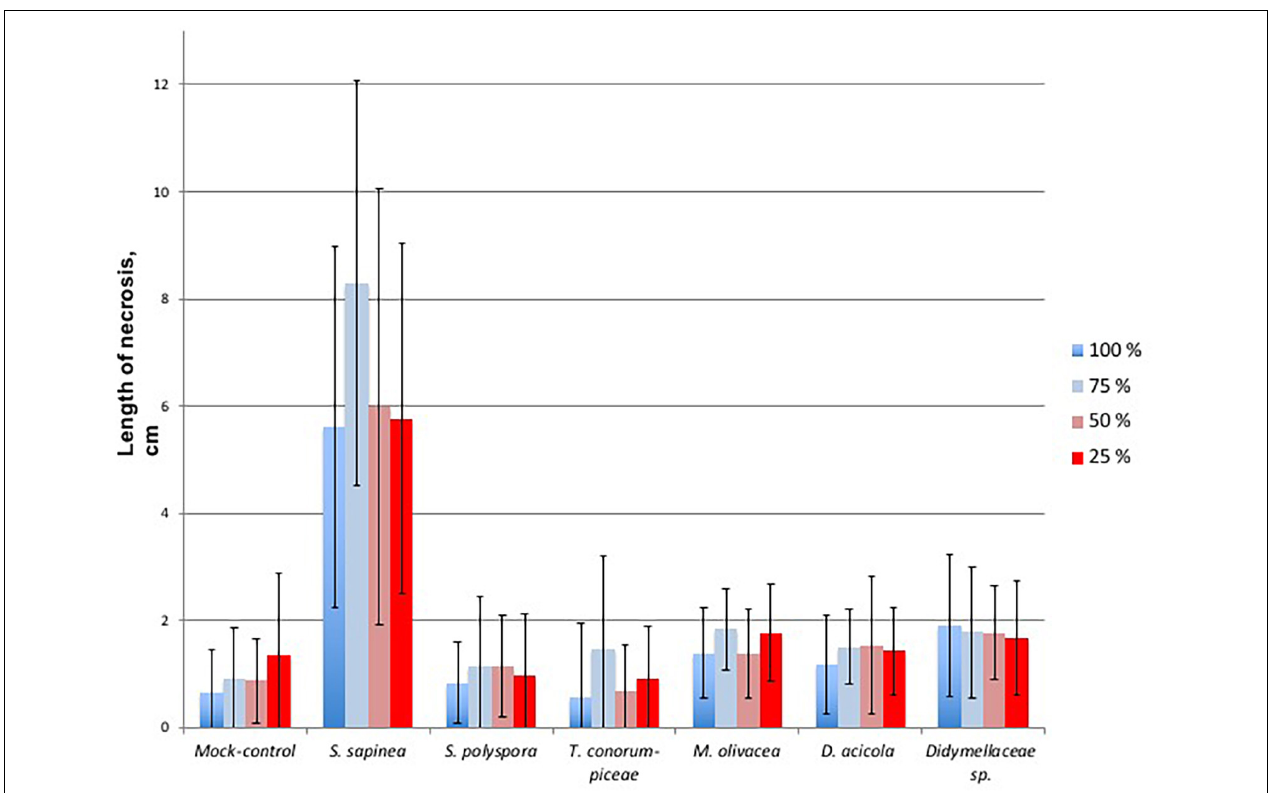
FIGURE 7 | Necrosis length of the single infected shoots per fungal isolate, each in relation to the water treatment groups, where blue is 100% water treatment, light blue 75%, light red 50%, and red 25%. The bars represent standard